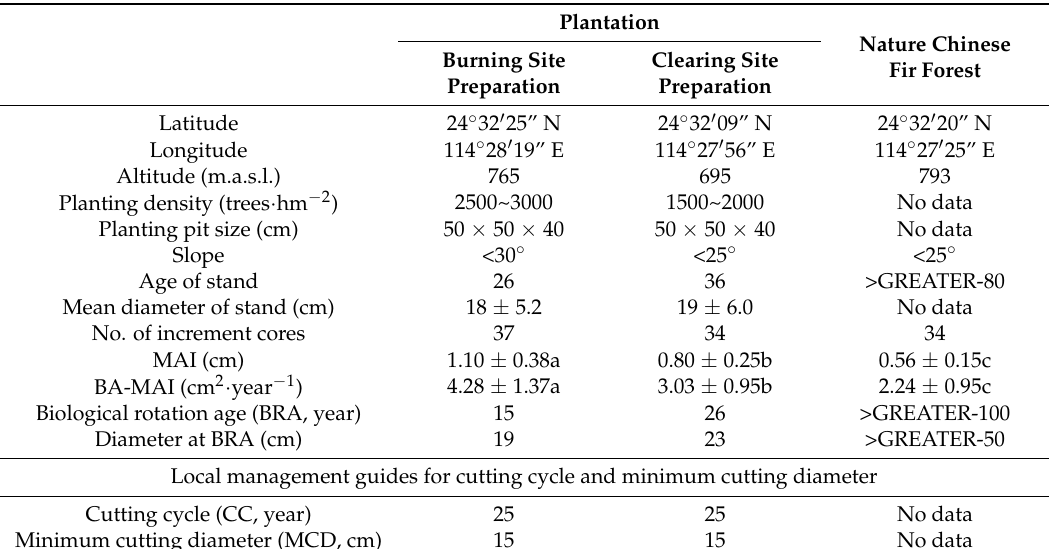
Table 1. The means of the mean annual basal area increment (MAI) and the BA-MAI for Chinese fir at different sites in the Nanling district in southern China.